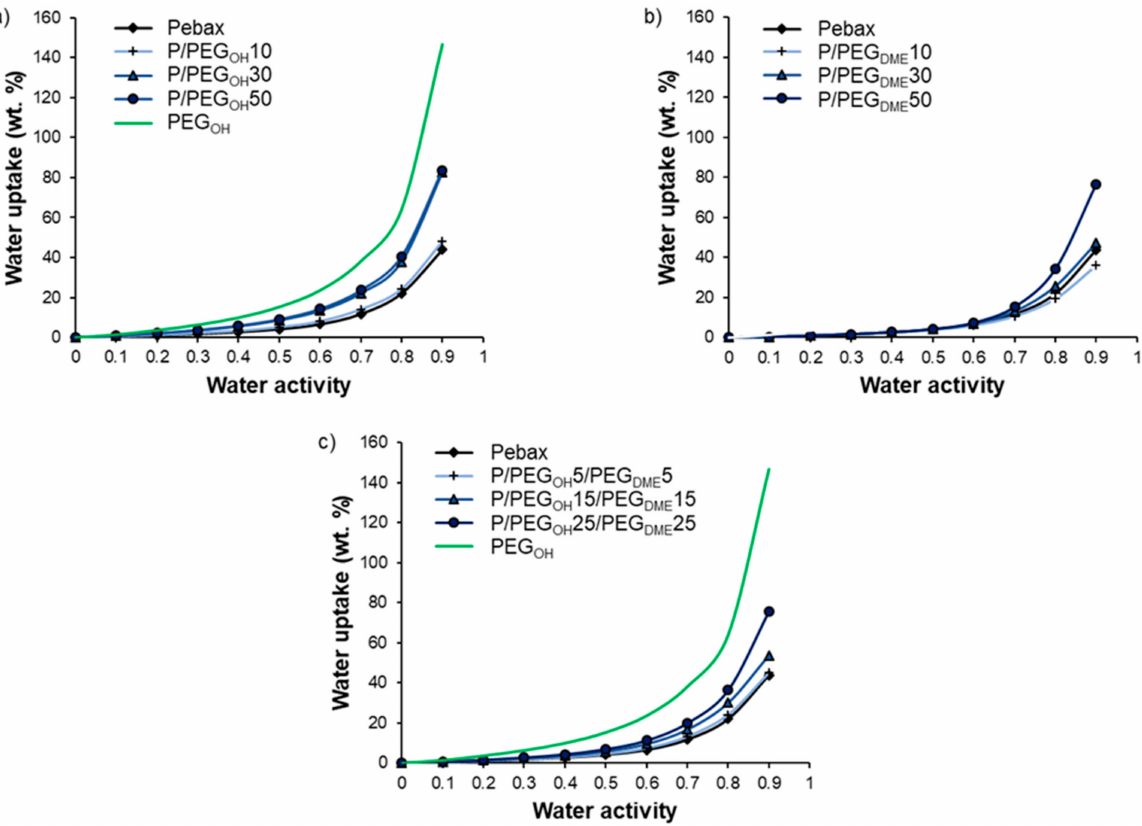
Figure 9. Water vapor sorption isotherms of Pebax ® /PEG OH films ( a ), Pebax ® /PEG DME films ( b ), and Pebax ® /PEG OH /PEG DME films with a 50/50 wt.% PEG OH /PEG DME ratio ( c